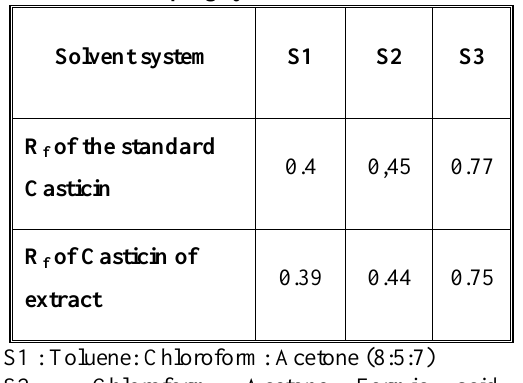
Table 2: R values of flavonoid (casticin) as f compared with the standard reference in different developing systems in TLC.